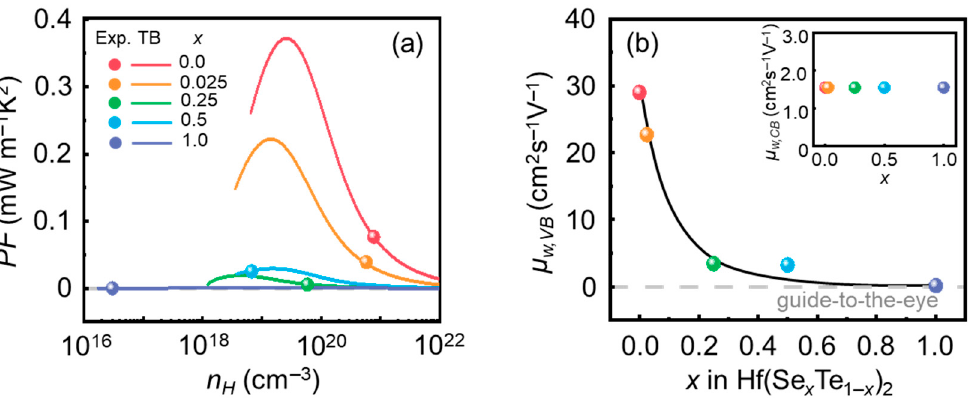
Figure 3. ( a ) Experimental (symbols) and theoretical (lines) power factor ( PF ) in terms of n H for Hf(Te 1 − x Se x ) 2 ( x = 0.0, 0.025, 0.25, 0.5, and 1.0) at 300 K [22], ( b ) estimated μ W , VB (= μ W for holes) in terms of Se alloying content ( x ) at 300 K. The x -dependent μ W , CB (= μ W for electrons) at 300 K is pro- vided in the inset.